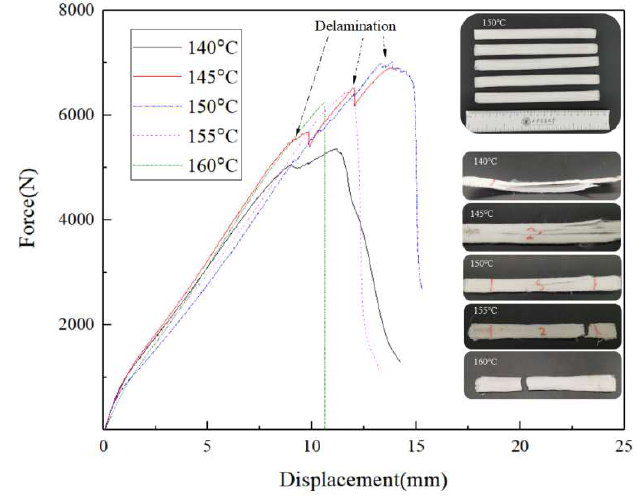
Figure 6. Force and displacement curves of CFSRCs obtained at various temperatures.